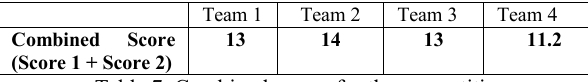
Table 7. Combined scores for the